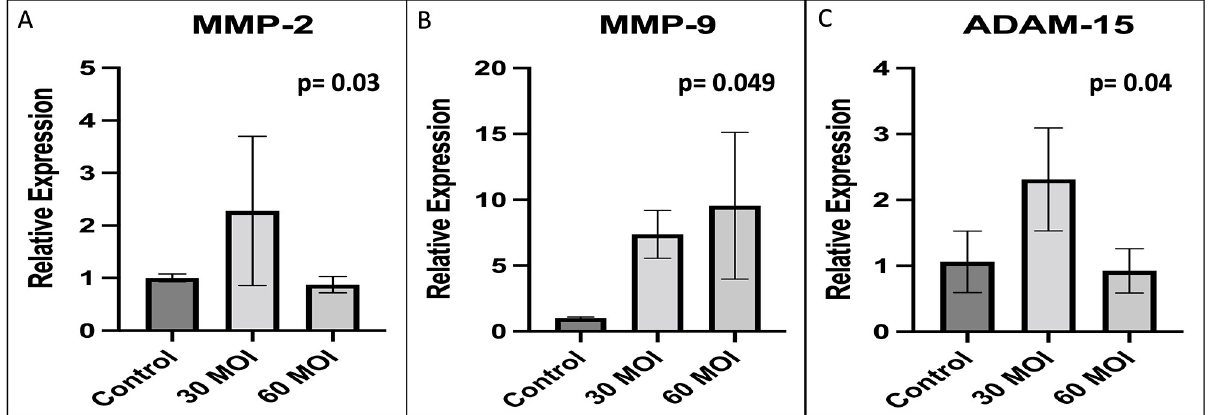
Fig 4. Comparison of metalloproteinase levels. A comparison of metalloproteinase expression as measured by real time PCR demonstrating that A) MMP-2, B) MMP-9, and C) ADAM-15 are increased in HUVECs after H1N1 infection at multiplicity of infection of 30 and 60.